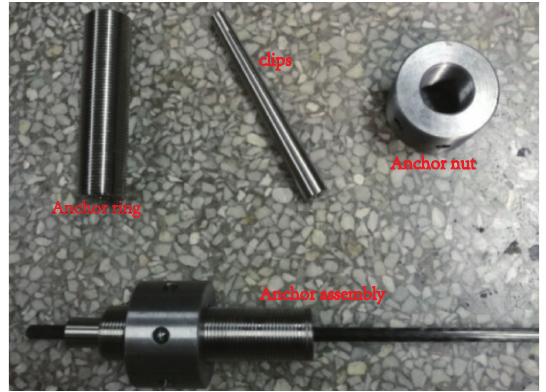
Figure 2. Integral clip-type anchor.